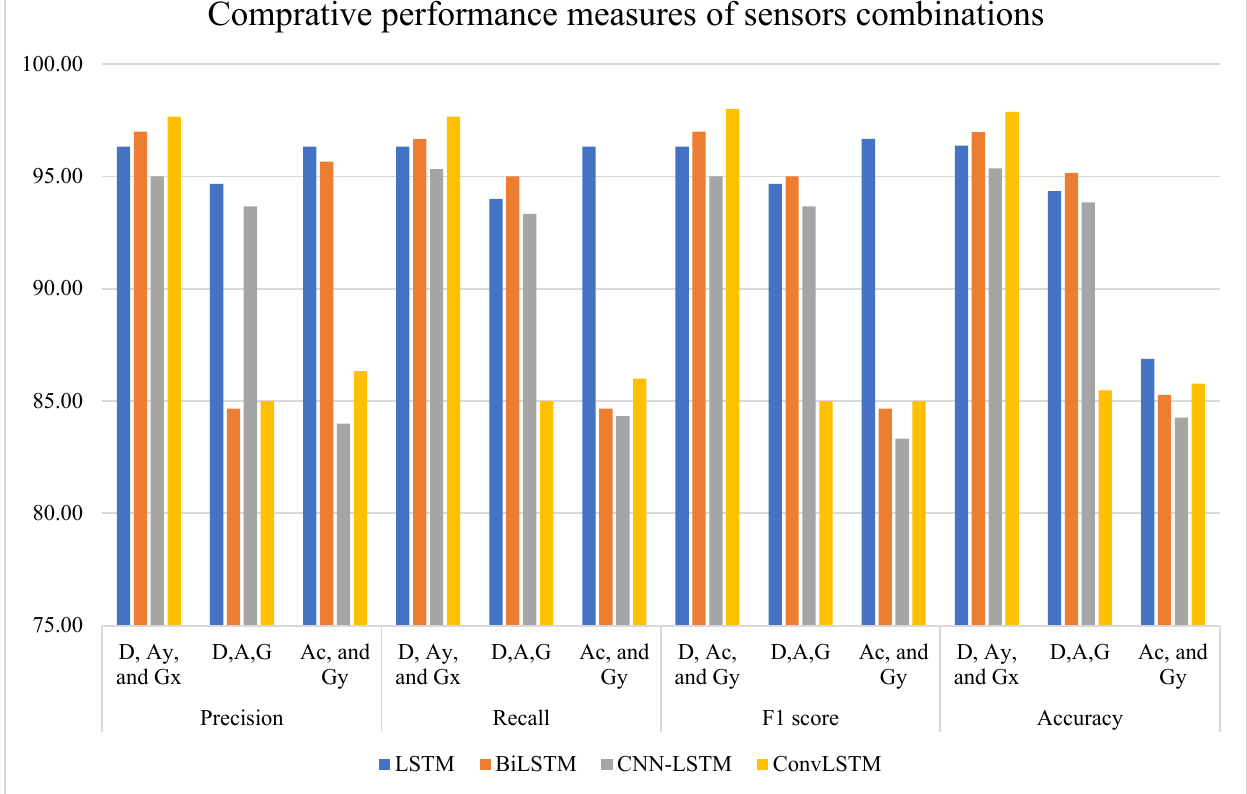
Figure 8. Identification of best-performing sensor combination (a z + g x + D) from the comparative result of all considered sensor combinations with LSTMs .